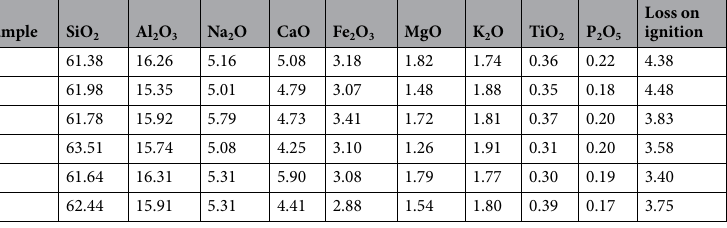
Table 1. The main chemical compositions of (a) RMF, (b) MMF-H2.5, (c) MMF-OH3.0, (d) MMF-La5.0, (e) CMMF-400 and (f) CMMF-H2.5-400 (wt.%).